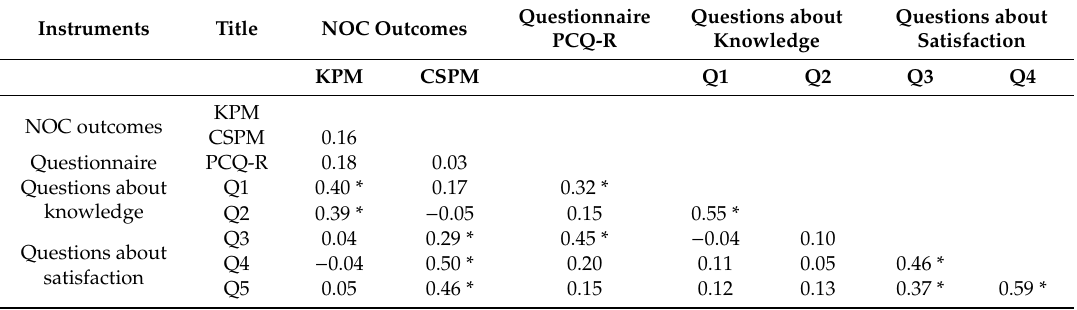
Table 6. Matrix of correlations between the scores obtained for the outcome Knowledge: Pain management and the scores for other instruments and ad-hoc questions (multitrait-multimethod matrix). Instruments